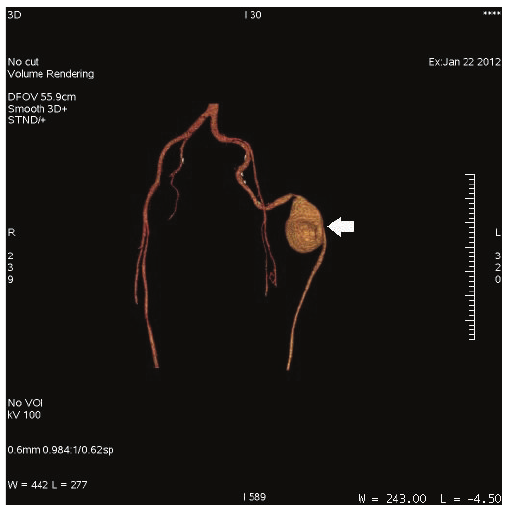
Figure 5: CT angiogram. The arrow shows the complete type of persistent sciatic artery with aneurysmal